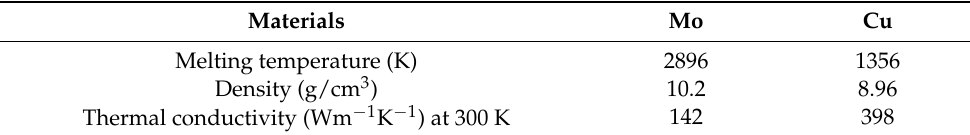
Table 1. Thermo-physical properties of Mo and Cu plates